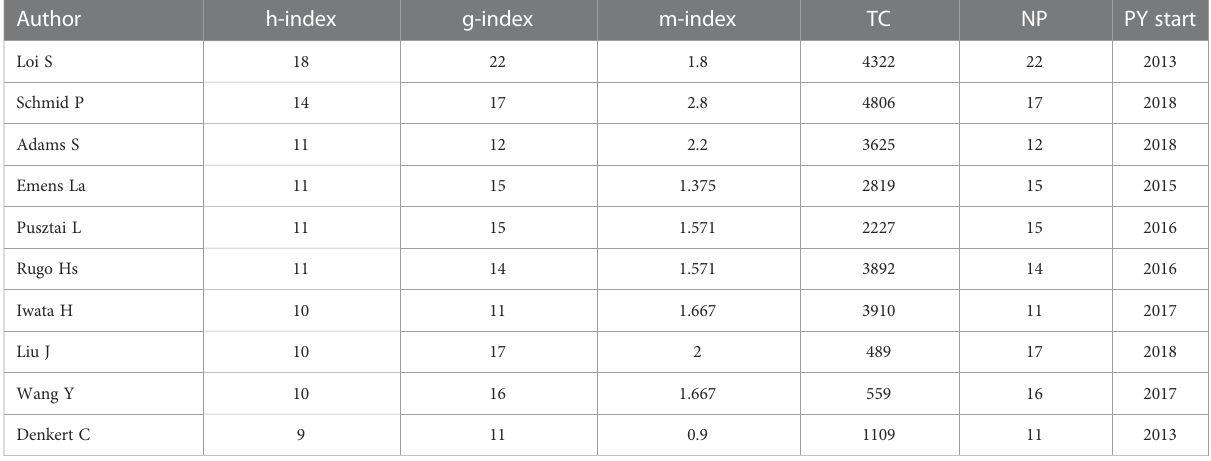
TABLE 2 Top 10 most in fl uential